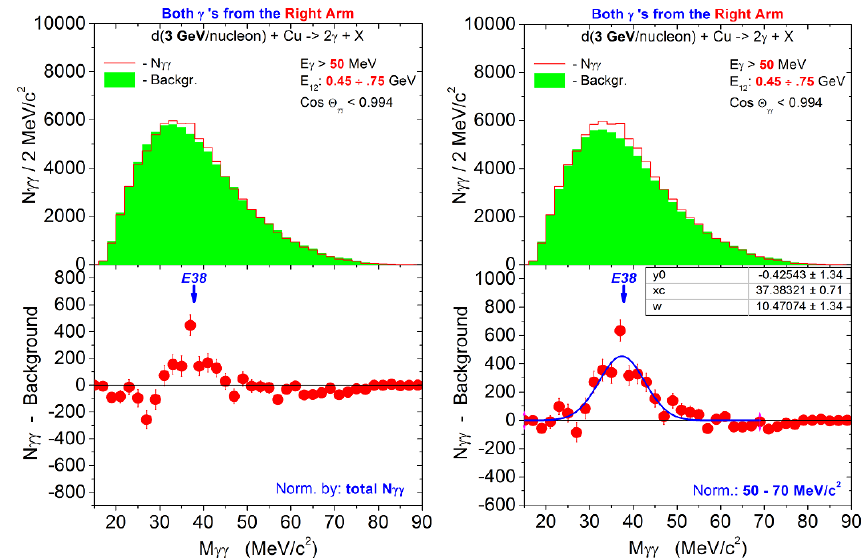
Figure 3. Invariant mass distributions (per 2 MeV / c 2 ) of γγ pairs satisfying criteria (i)-(iii) (criteria (A)) without (upper panels) and with (bottom panels) the background subtraction obtained for the reaction d + Cu → γ + γ + X at 3.83 GeV / c per nucleon. The top shaded histograms show the background contribution. The background is normalized to the total pair number (left) and to the number of pairs in a range of masses 50 - 70 MeV / c 2 (right). The curve is the Gaussian approximation of the experimental points in the range (14; 70) MeV / c